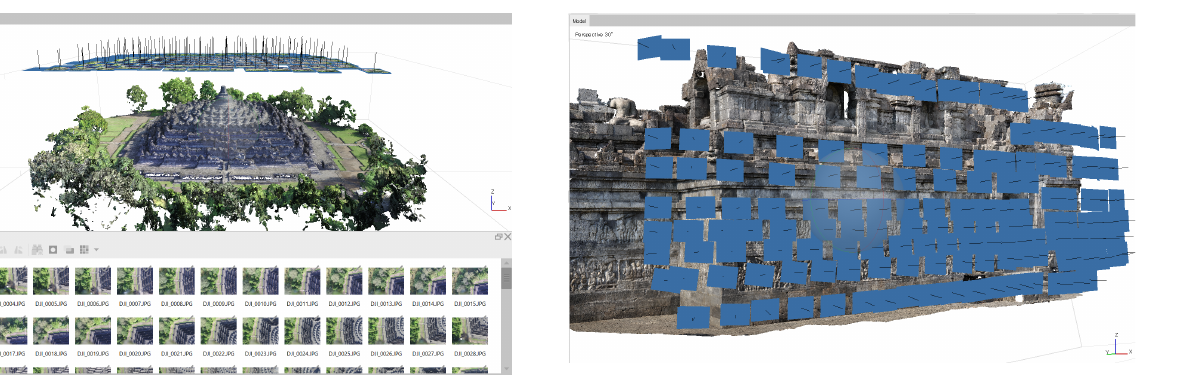
Figure 3. Example of the camera positions for reconstructing the whole temmple building by means of photogrammetry.